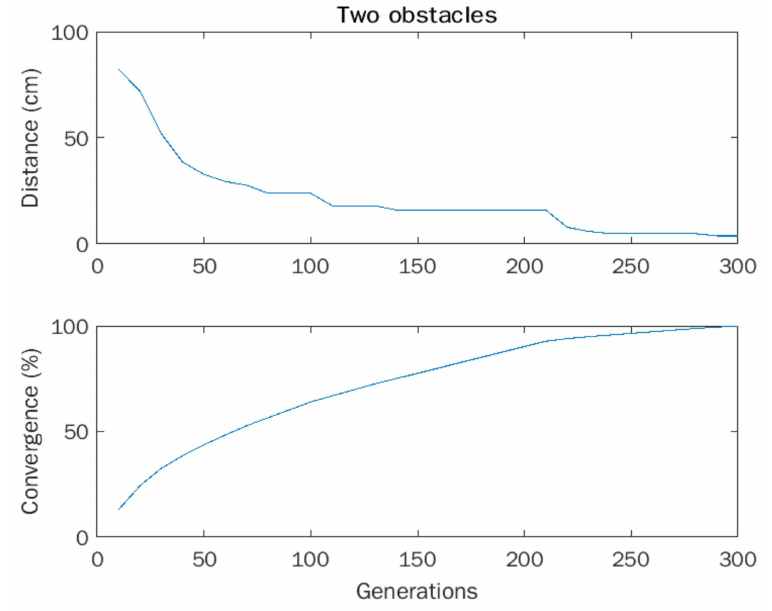
Figure 15. Results of experiment